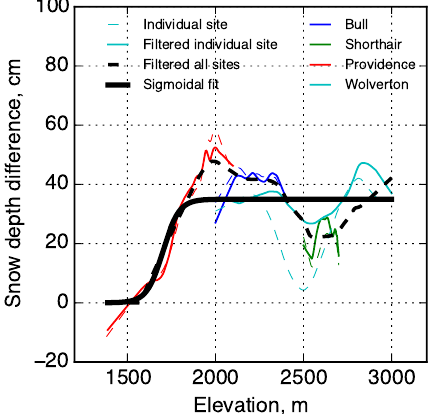
Figure 11. Snow-depth difference between open and under-canopy areas versus elevation, calculated as difference between raw 1m pixel snow depth and northness-filtered 1m pixel snow depth, to- gether with the sigmoidal fit of the snow-depth